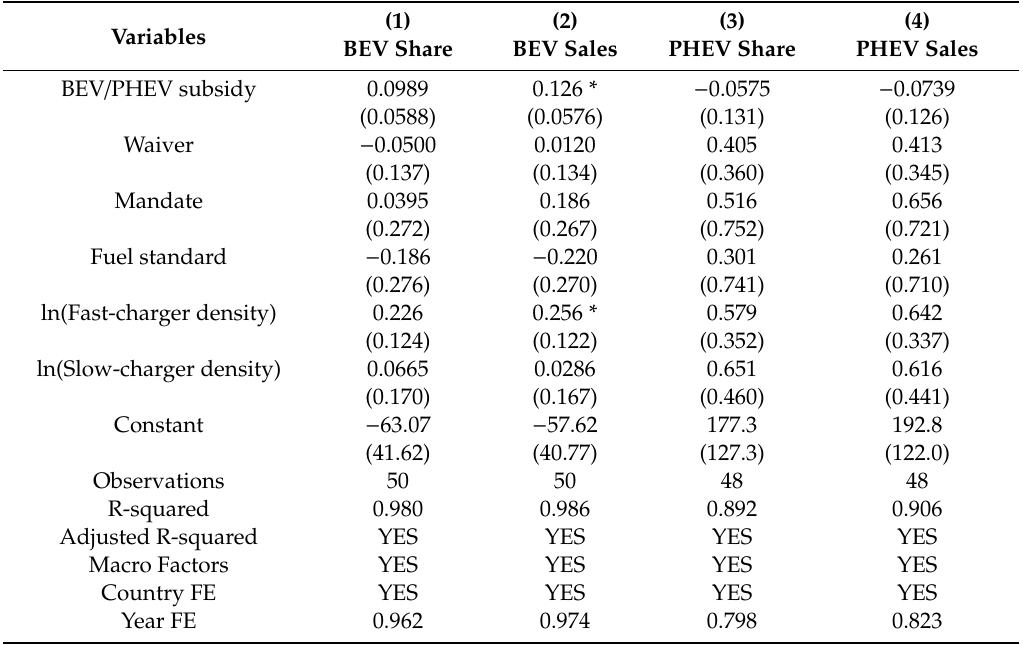
Table 9. Policy impact on the battery electric vehicle (BEV) market and plug-in hybrid electric vehicle (PHEV)